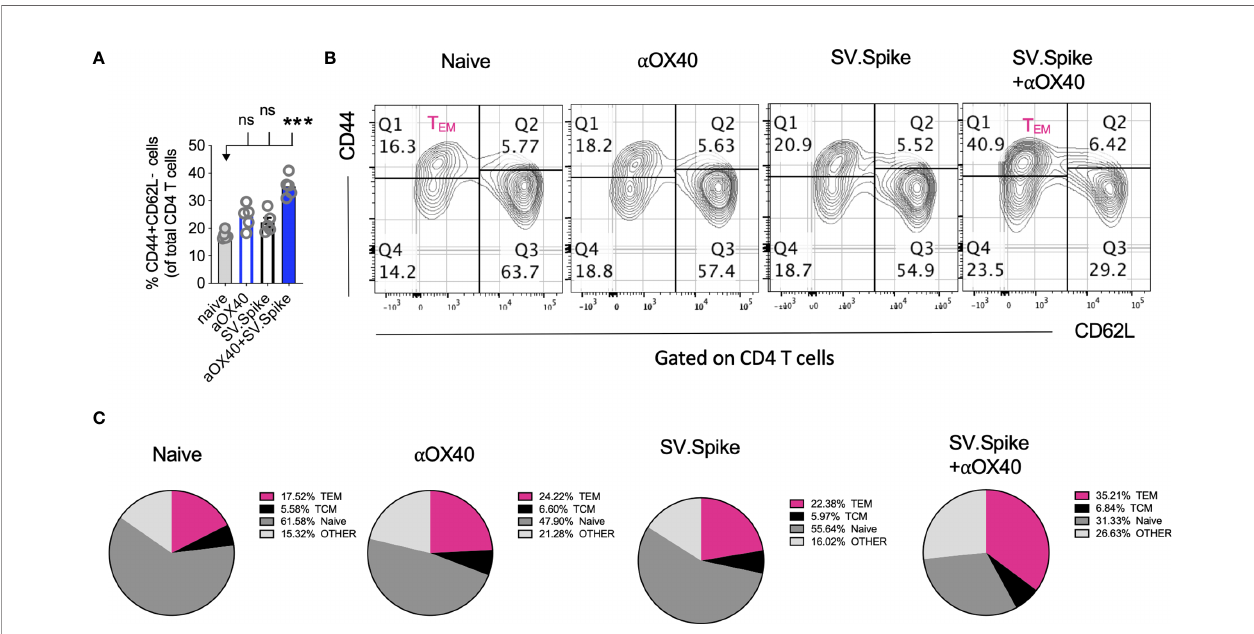
FIGURE 10 | Combination of SV.Spike and a OX40 potentiates CD4 effector memory T cells 14 weeks after prime vaccine doses. Splenocytes from indicated immunized C57BL/6J mice groups were harvested 14 weeks after fi rst vaccine doses. Memory phenotype was characterized in spleen from indicated groups by fl ow cytometry by gating on CD4+ cells. The percentage of effector CD4+ memory T cells, indicated by CD44+ CD62L − CD4+ markers, was analyzed and shown (A) . (B) Representative contour plots and (C) pie charts. (n=5 mice per group). TCM= CD44+CD62L+ double positive central memory T cells; TEM= CD44+ CD62L − effector memory T cells; naïve= CD44 − but CD62L+ T cells, other= CD44 − and CD62L − T cells. n.s. > 0.05, ***p ≤